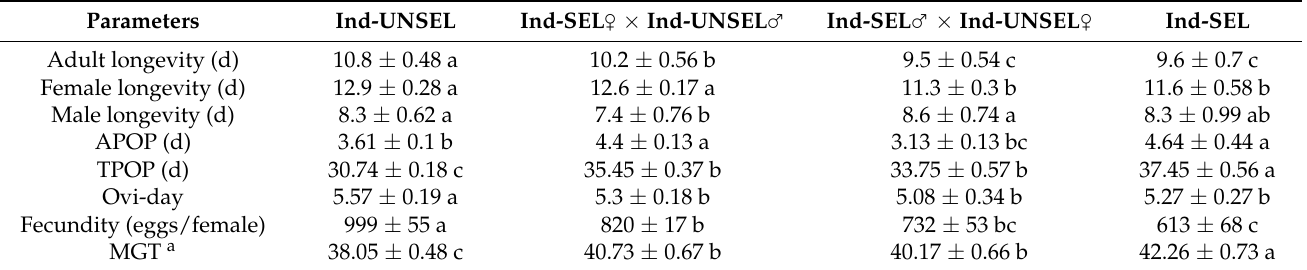
Table 6. Adult longevity (d), APOP, TPOP, Ovi-day, Fecundity, and MGT (Mean ± SE) of S. frugiperda